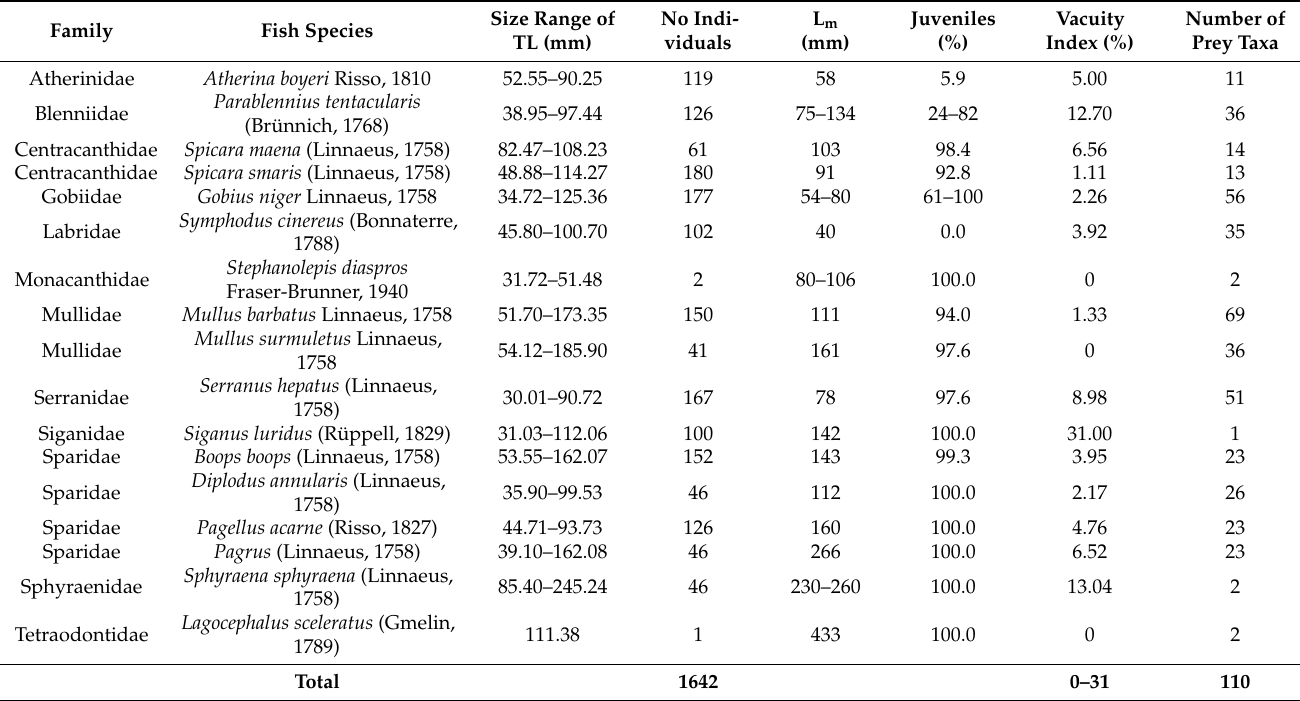
Table 1. Fish species and number of specimens examined for stomach content analysis during all six sampling occasions in the study area. The numbers of empty stomachs, in terms of vacuity index, are also shown. Size range of the total length (TL) of the fish specimens is given. L m : length at first maturity for each species is also included.